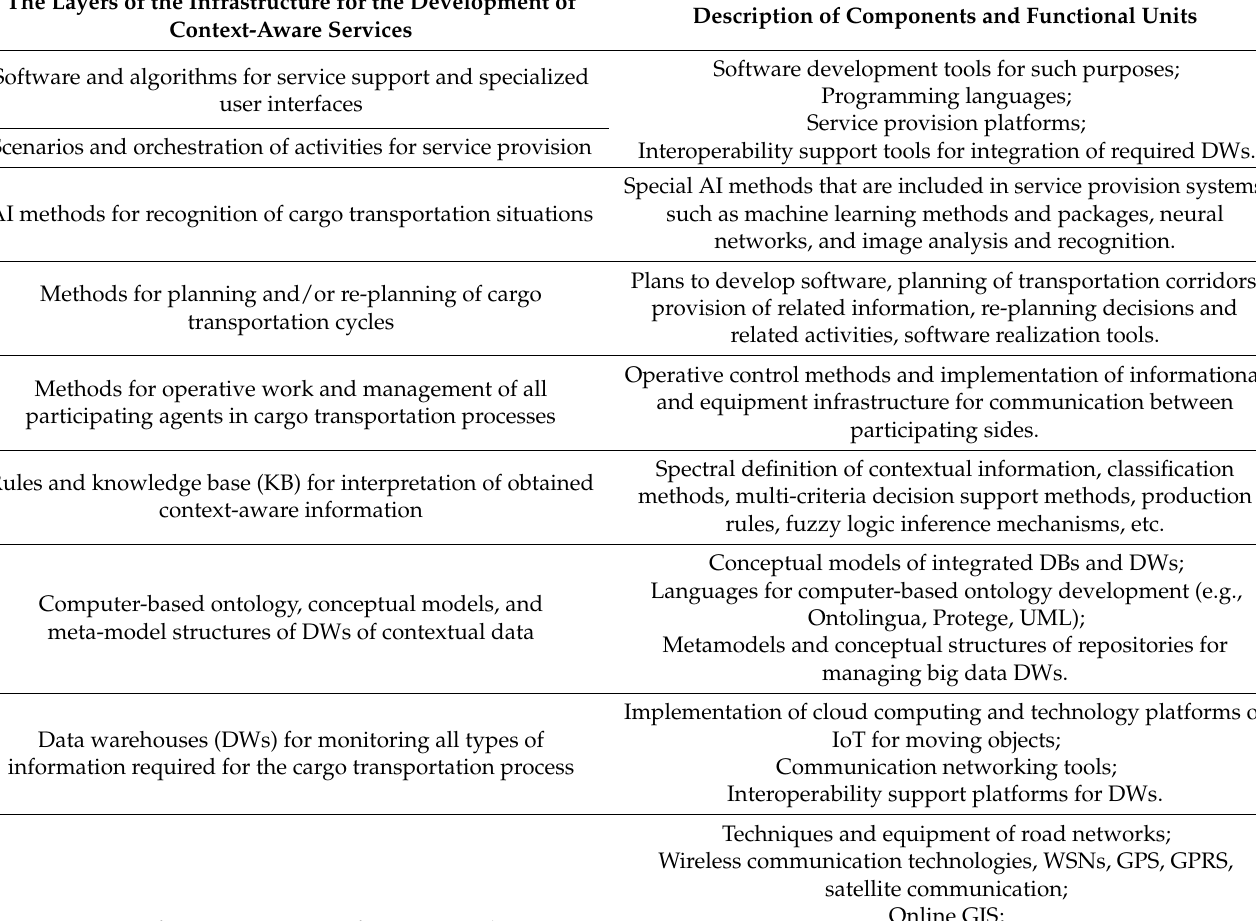
Table 2. Approach for the representation of layers of the adaptable smart service provision system based on context-aware information of cargo transportation